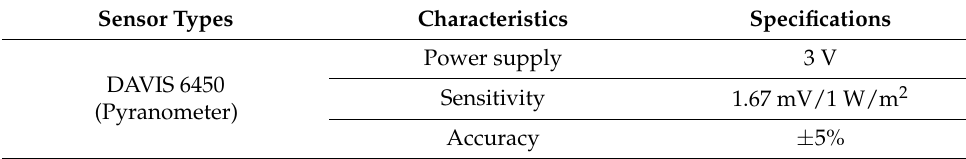
Table 1. Specifications of sensor